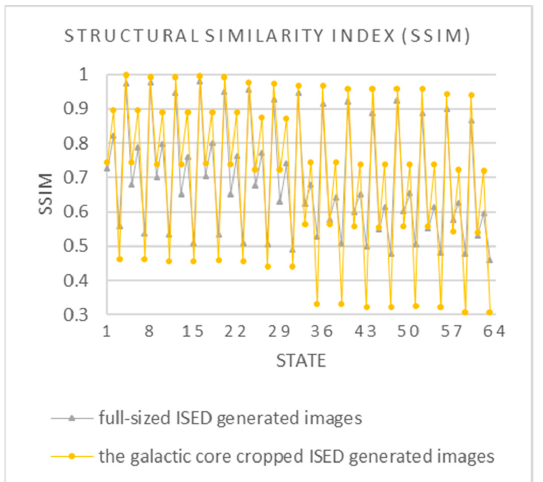
Figure 10. SSIM values of 63 ISED-generated images. The cropped images of M87 can be seen in Figure